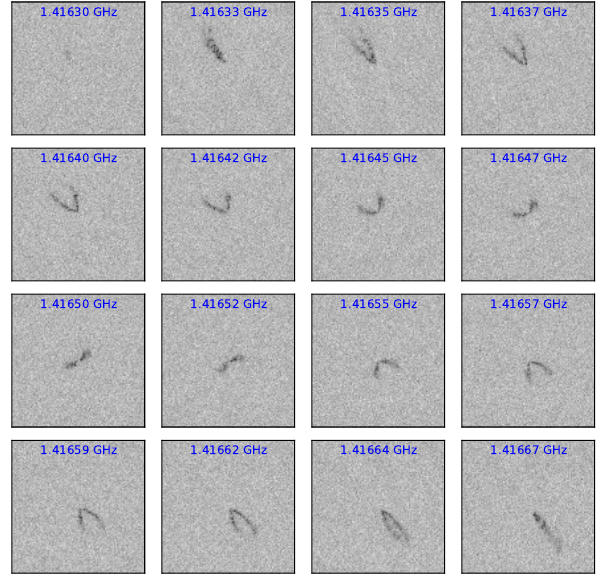
Fig. 22.— 16 of the 72 channels recorded for the galaxy NGC 3198, from the THINGS survey (Walter et al. 2008), [http://www.mpia.de/THINGS/] different regions within the spectrum. In this particular